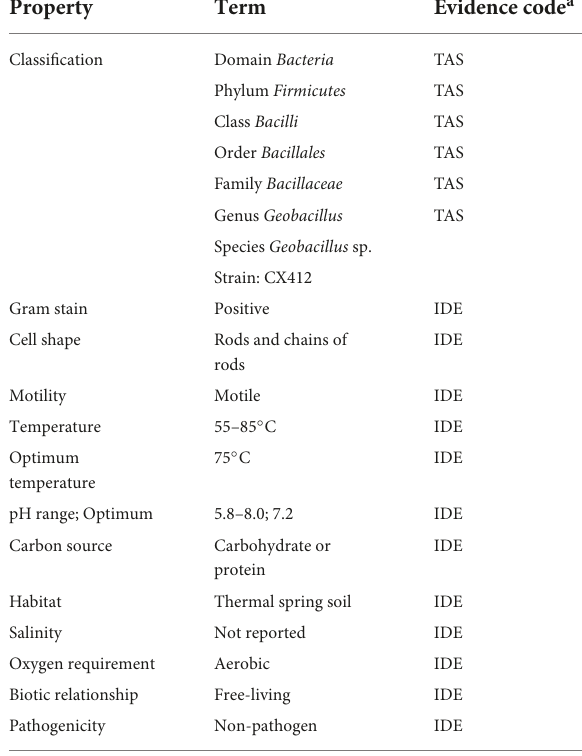
TABLE 1 Classification and general features of Geobacillus sp.